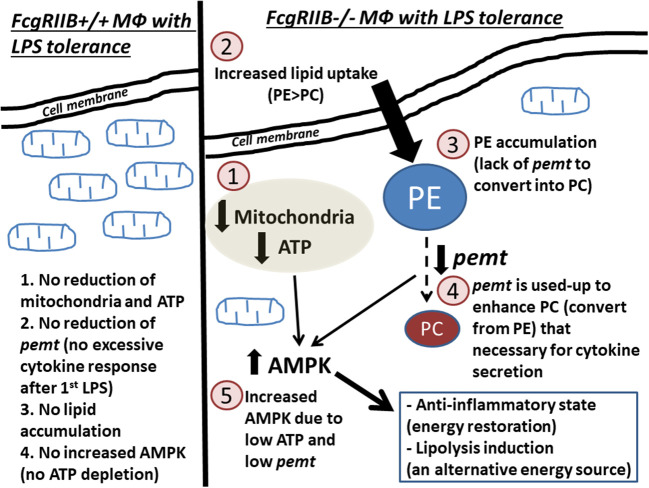
Diagram of the proposed hypothesis is shown. In wild-type macrophages, LPS-tolerance does not induce extreme energy depletion because no exaggerated cytokine production after the first LPS stimulation (left side of the figure). In contrast, in FcgRIIB–/– macrophages (right side of the figure), LPS-tolerance induces severe energy depletion (mitochondria and ATP) (1), which is possibly due to the extreme cytokine production after the first LPS stimulation from inhibitory signaling loss. Subsequently, lipid uptake (2) is increased in response to cell-energy depletion. Conversion from phosphatidylyethanolamine (PE) into phosphatidylcholine (PC) is reduced (3) from inadequate pemt (4), which is consumed during profound cytokine secretion process (23, 24) after the first LPS stimulation. In parallel, AMPK (5), in response to ATP depletion, restores cell energy through reduced cytokine production (56) leading to LPS-tolerance.